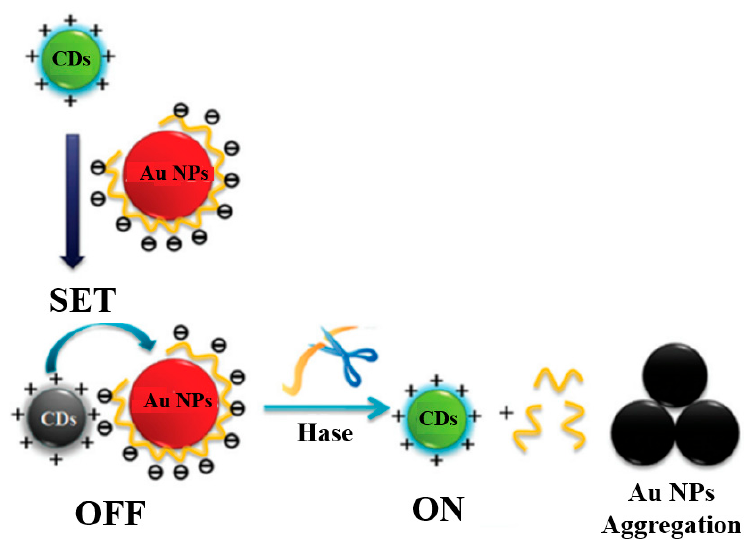
Figure 20. Schematic illustration of a novel SET biosensor system [89].